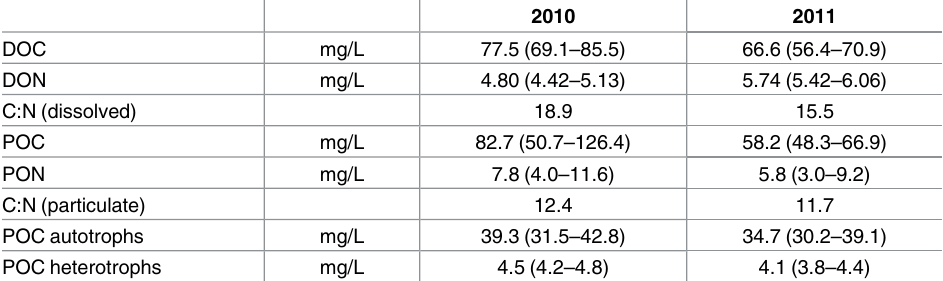
Table 7. Standing stocks (mean and range) of dissolved and particulate organic carbon (DOC and POC) and dissolved and particulate organic nitrogen (DON and PON) in the pelagic of Dziani Dzaha during 2010 and